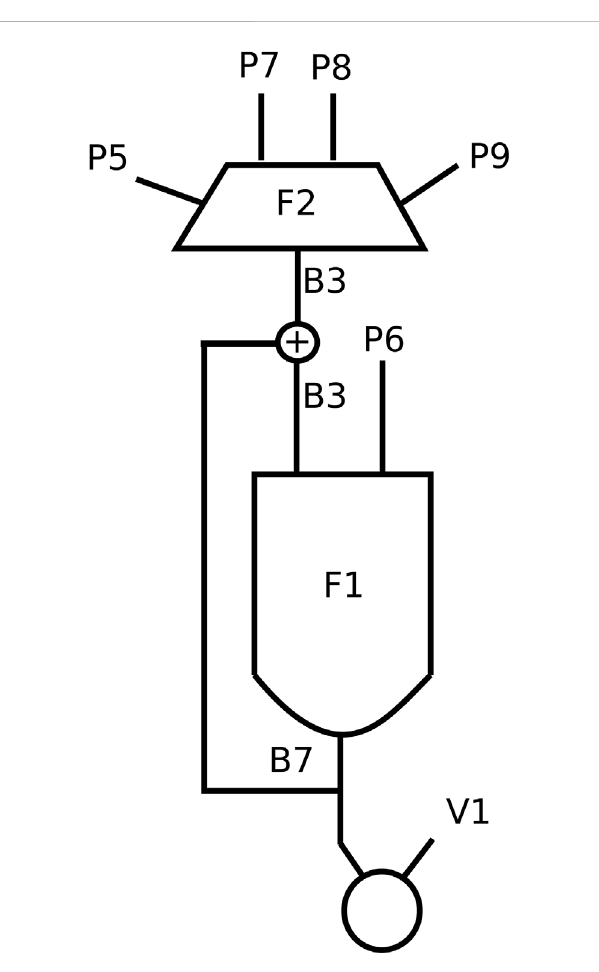
FIGURE 5 Fanfare instrument fl